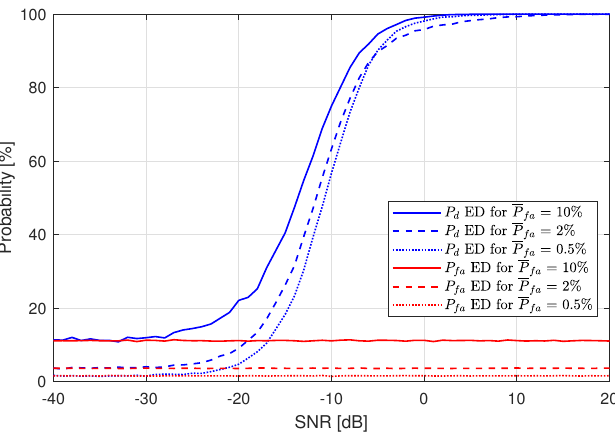
Figure 6. Probability of detection P d for the Energy Detection stage for ¯ P fa = 10%, ¯ P fa = 2% and ¯ P = 0.5%. fa